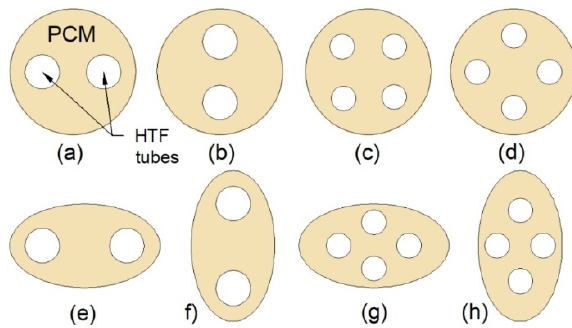
Figure 13. Cross-section of the TTHX: ( a ) Two horizontal inner tubes; ( b ) two vertical inner tubes; ( c ) four inner tubes; ( d ) four inner tubes with the modified arrangement; ( e ) horizontal elliptical outer tube and two inner tubes; ( f ) vertical elliptical outer tube and two inner tubes; ( g ) horizontal elliptical outer tube and four inner tubes; ( h ) vertical elliptical outer tube and four inner tubes [21].